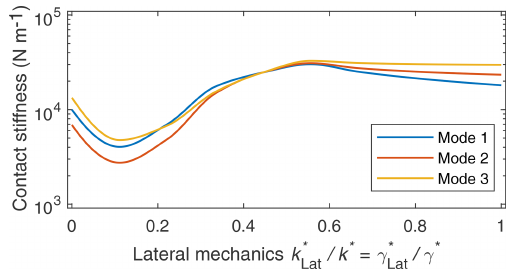
Figure 14. Calculated contact stiffness of the measured lowest Figure 15. Contact stiffness calculated from measurements on a three resonance peaks in dependence on lateral surface interactions. PnBMA polymer film. By performing calibrations, good agreement Best model consistency can be expected at the intersection point of between the modes of vibration is /k ∗ = γ ∗ /γ ∗ = 0 . 444. the three analyzed modes at k ∗ Lat Lat